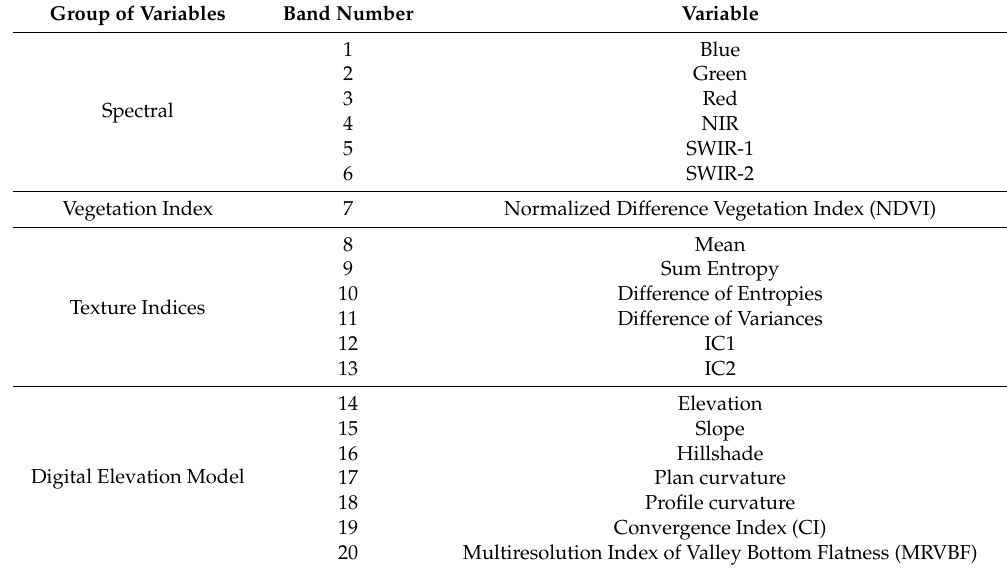
Table 2. Predictor variables used in the supervised classification used to perform a Land Cover (LC) Classification in Costa Rica for the years 1985/1986, 1991/1992, 1997/1998, 2000/2001, 2007/2008, 2011/2012 and 2013/2014. Bands 1–13 are derived from Landsat images spectral data and bands 14–20 are derived from the Digital Elevation Model from the Shuttle Radar Topography Mission (STRM 30